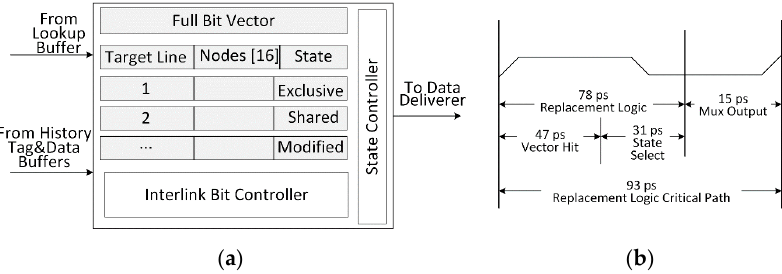
Figure 6. Architecture design on data replacement logic: ( a ) Hardware structure including full bit vector based directory logic and interlink bit controller; ( b ) Critical path latency of data replacement logic.